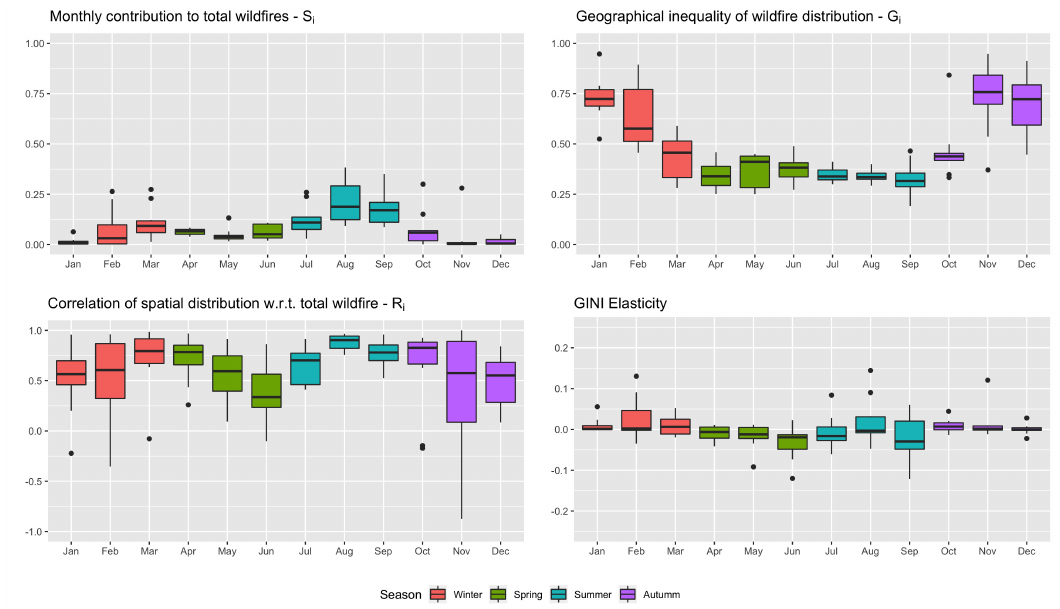
Figure 5. Spatial Gini decomposition of the number of wildfires per